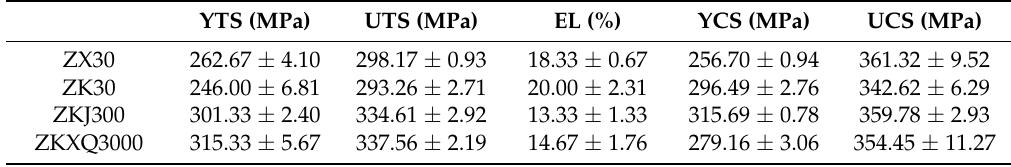
Figure 4. Fracture surface morphologies of the as ‐ extruded ZX30 ( a , e , i , m ), ZK30 ( b , f , j , n ), ZKJ300 ( c , g , k , o ), ZKXQ3000 ( d , h , l , p ) alloys. ( a – h ) tensile, ( i – p ) compression fracture surface morphology of the four alloys. Table 1. Mechanical properties of as ‐ extruded ZX30, ZK30, ZKJ300 and ZKXQ3000 alloys.